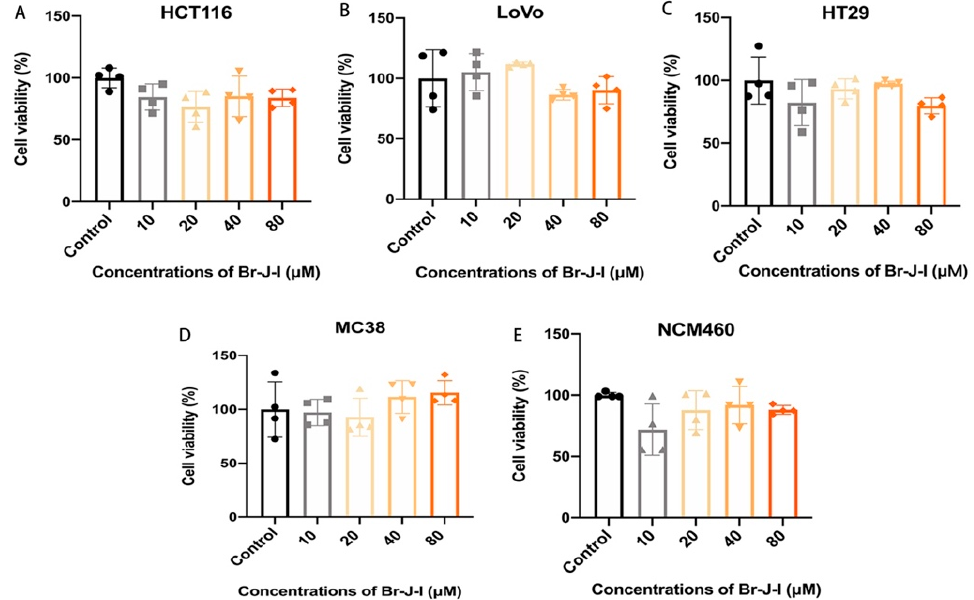
Figure 4. Cell viability of various CRC cell lines and colon epithelial cells in the presence of Br-J-I. Cell viability of human colon cancer cells HCT116 ( A ), LoVo ( B ), HT29 ( C ), murine colon cancer cells MC38 ( D ), and human colon epithelial cells NCM460 ( E ) treated with different concentrations of Br-J-I for 72 h.